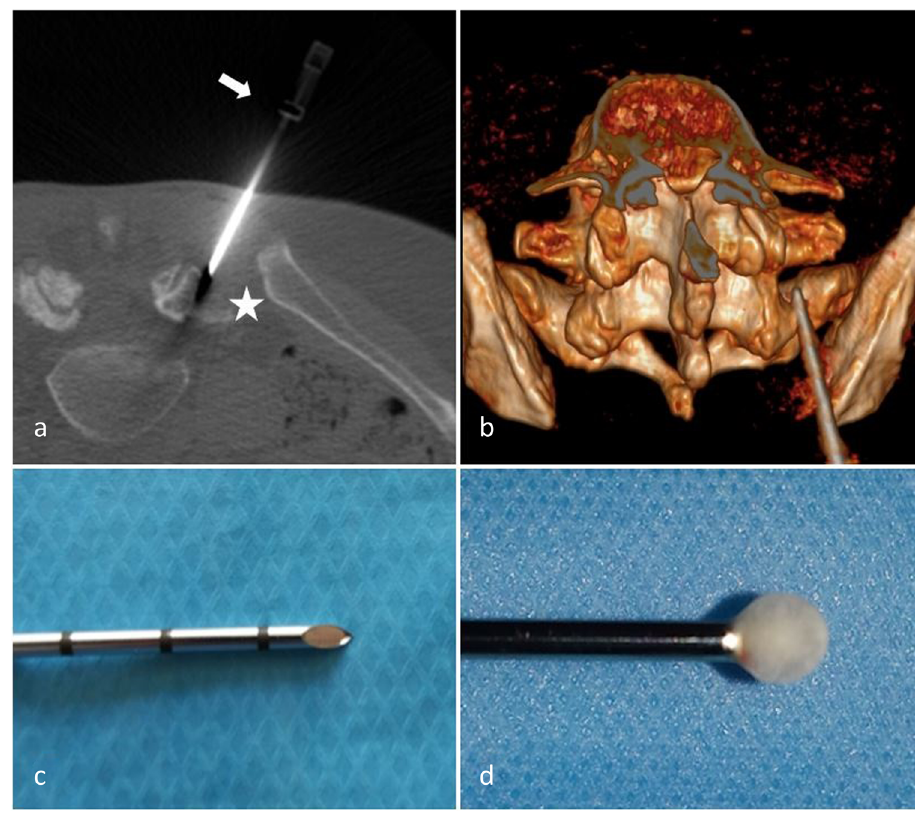
cryoneurolysis. CT-guided cryoablation at the right L5-S1 level. a : Anatomically accurate cryoprobe (white arrow) place- ment with the target midway be- tween the upper end and middle of the ala of the sacrum (white star). b : 3D reconstruction show- ing the same cryoprobe place- ment. Cryoprobe needle tip ( c ): ice-ball formation at the cryo- probe tip (Joule – Thompson ef- fect) ( d